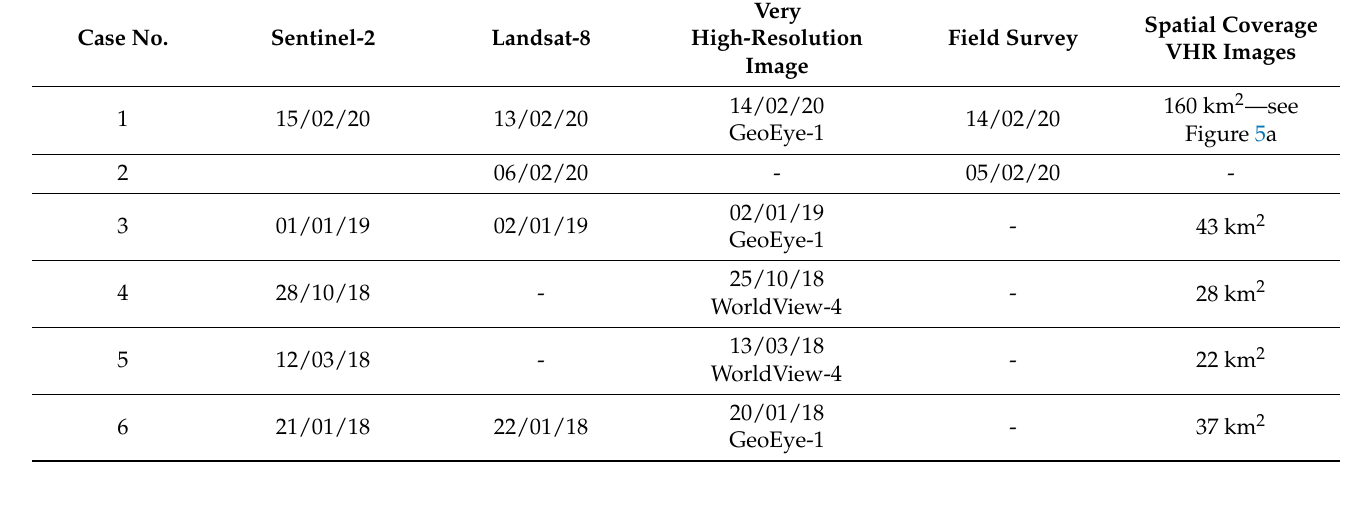
Table 4. Acquisition dates of the data used for the validation tests.